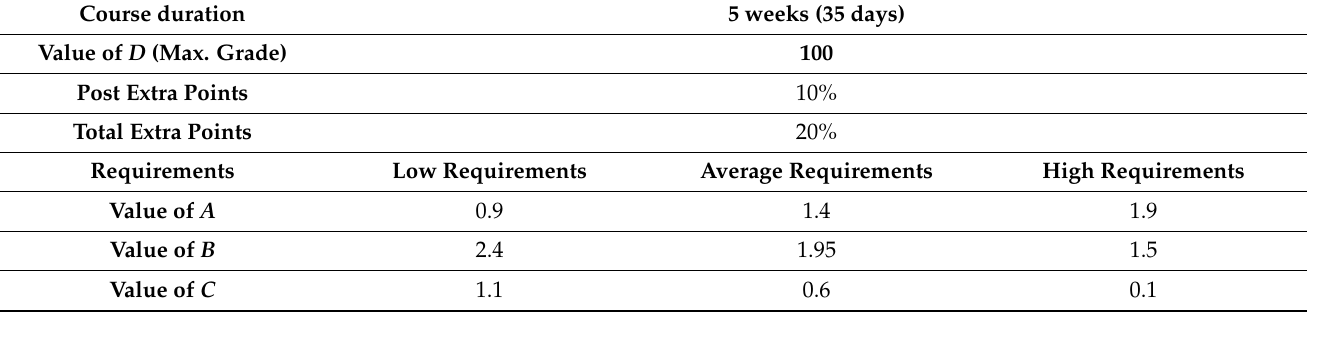
Table 4. Input Values.